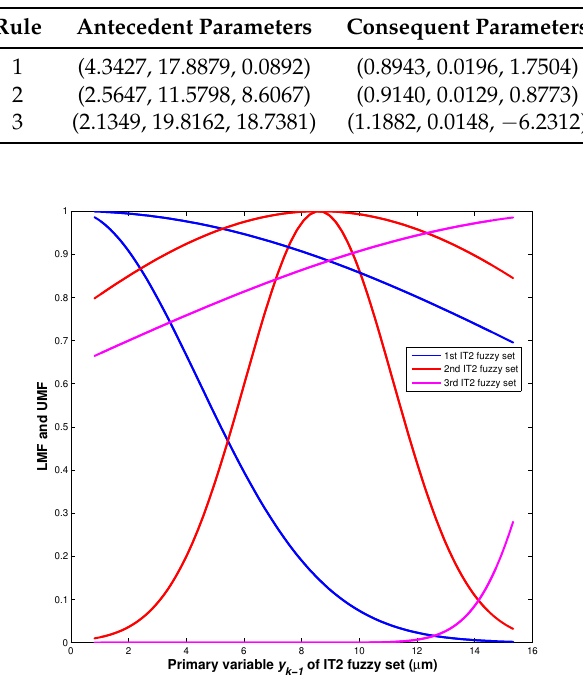
Figure 3. LMF and UMF of the identified IT2 fuzzy